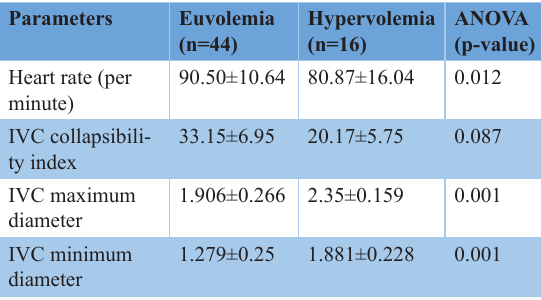
Table 2. Parameter assessment with volume status